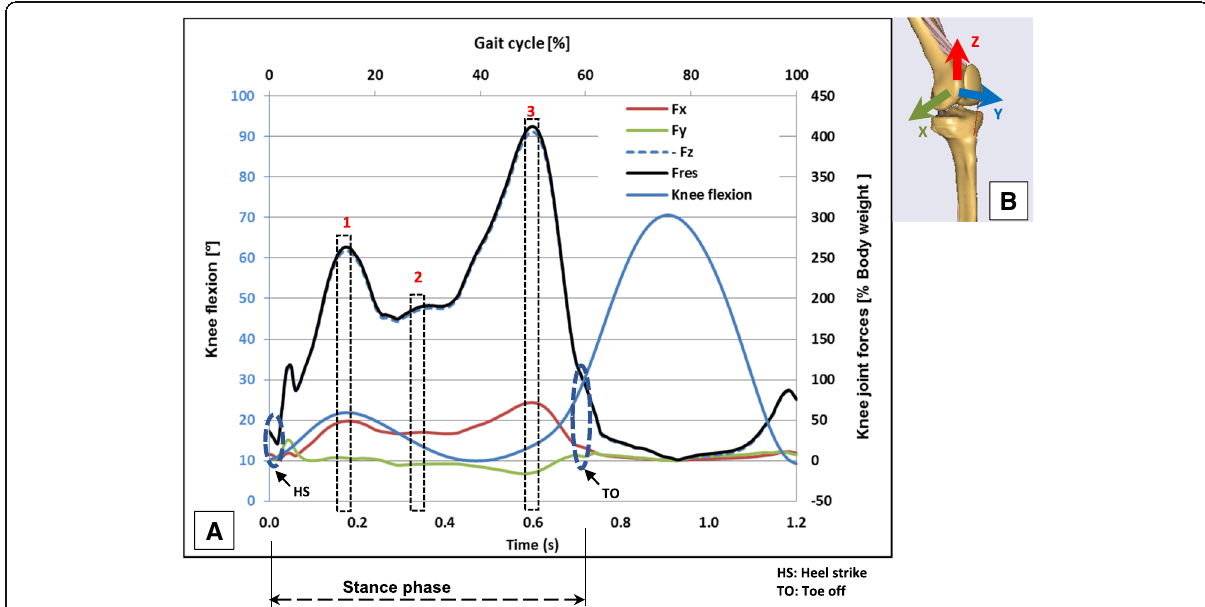
Fig. 3 The three analysed positions: a Components of the knee joint forces and knee joint flexion angle over the complete gait cycle. b Coordinate system used to define the calculated knee joint